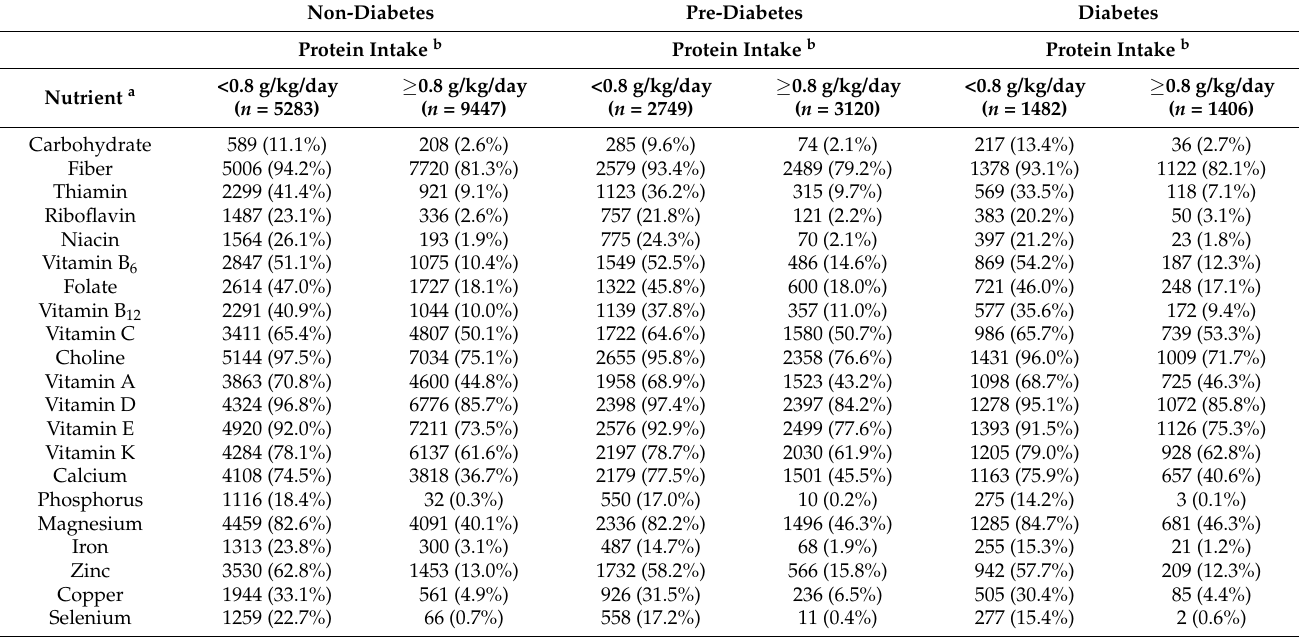
Table 3. Proportion consuming less than the Recommended Intakes across diabetes categories and not meeting the protein